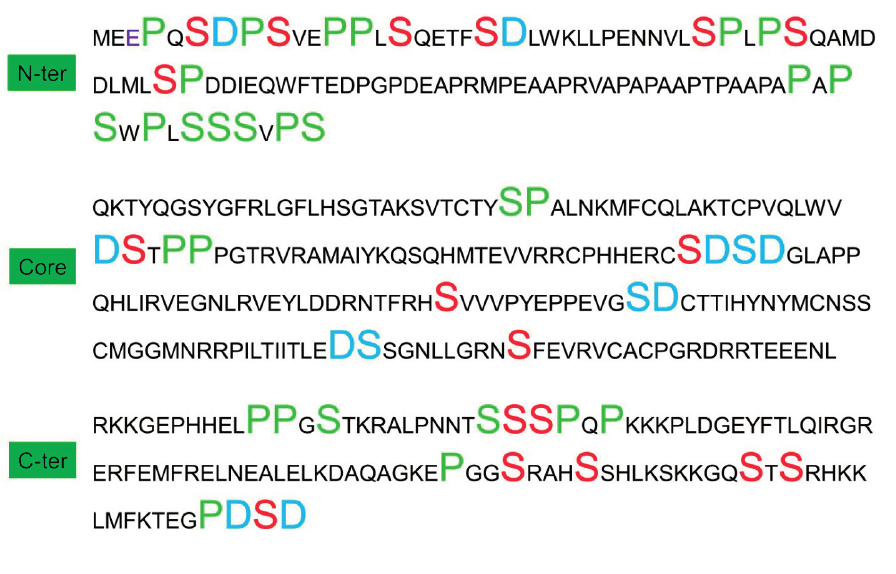
Figure 3. Distributions of D/S and P/S amino acids pairs in p53 indicate that the correlation of D/S (in X X Y position, green large fonts) are mostly near phosphorylation sites. The known i i+3 phosphorylation sites for Ser are in red